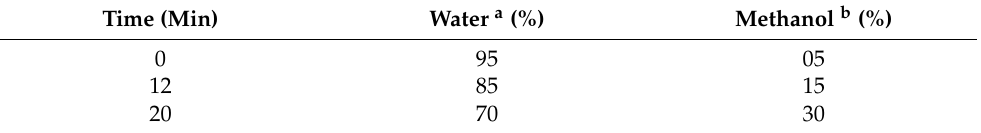
Table 1. HPLC elution condition employed for constituent identification of Allium sativum